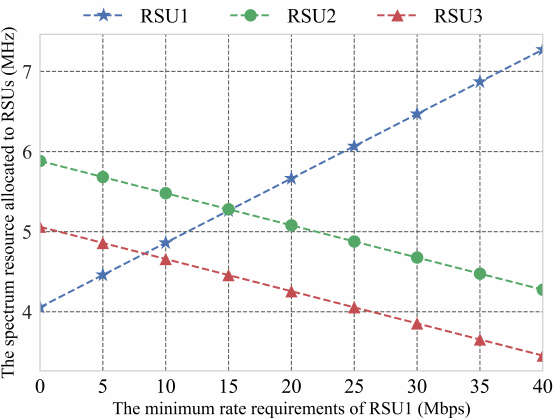
Figure 4. The spectrum allocation results of RSUs vary with the minimum rate requirements of RSU1.